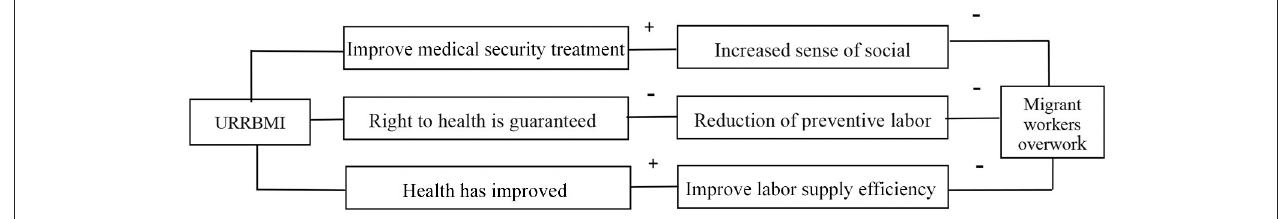
FIGURE 1 | Action path of urban-rural medical insurance integration on migrant workers’